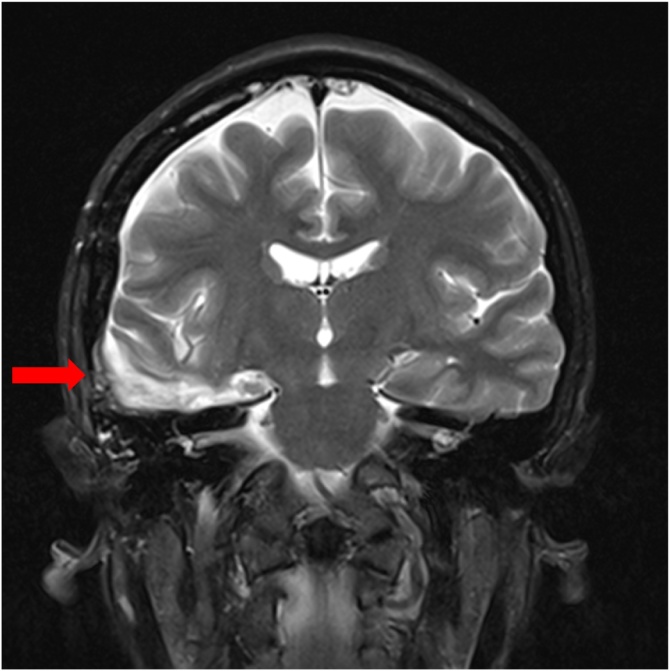
MRI Brain T2 weighted (coronal view) demonstrating post-surgical changes following right anterior temporal lobectomy.